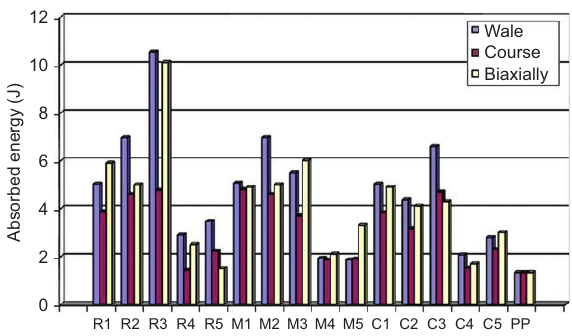
Figure 11 Charpy test results for composites.